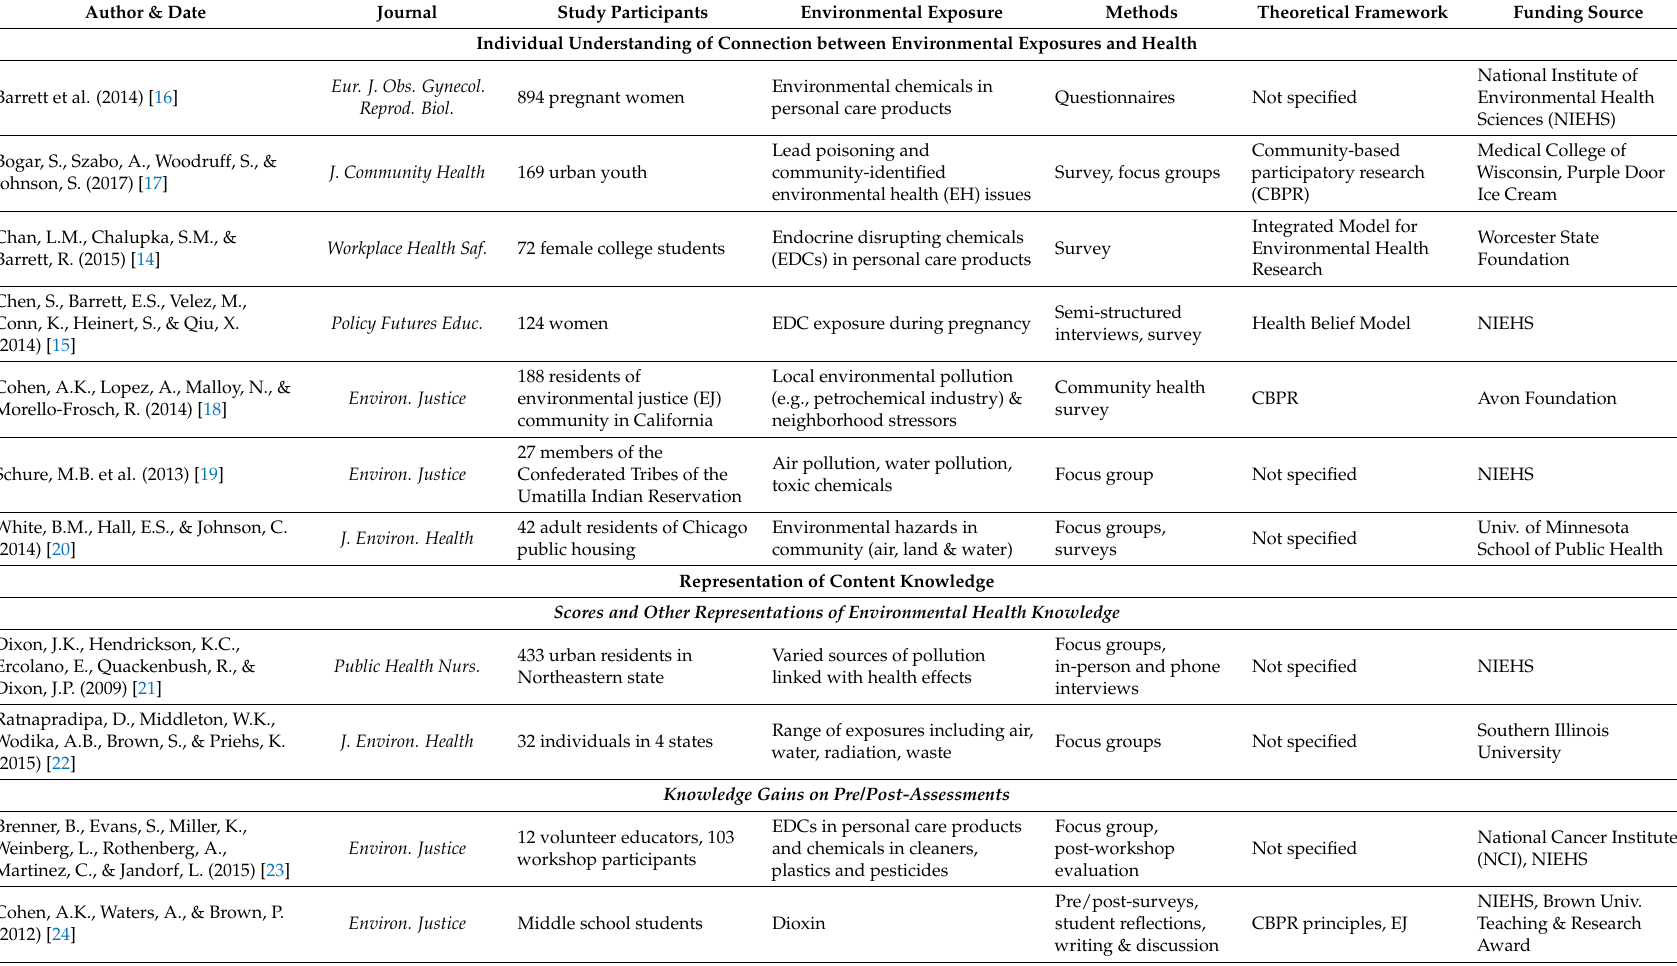
Table 1. Articles that Inform the Characterization and Measurement of Environmental Health Literacy